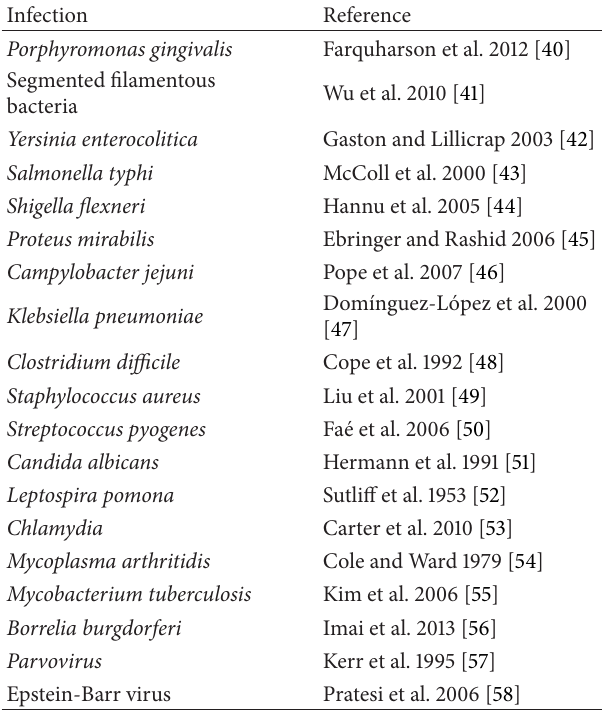
Table 1: Infectious agents associated with rheumatoid arthritis.